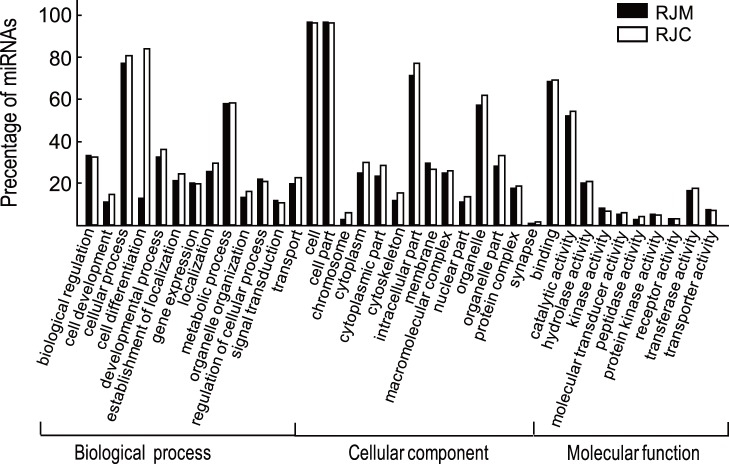
Gene Ontology classification of miRNAs in RJM and RJC.The results are summarized in three main categories: biological process, cellular component and molecular function. The Y-axis indicates the precentage of miRNAs in a category. The X-axis indicates category.